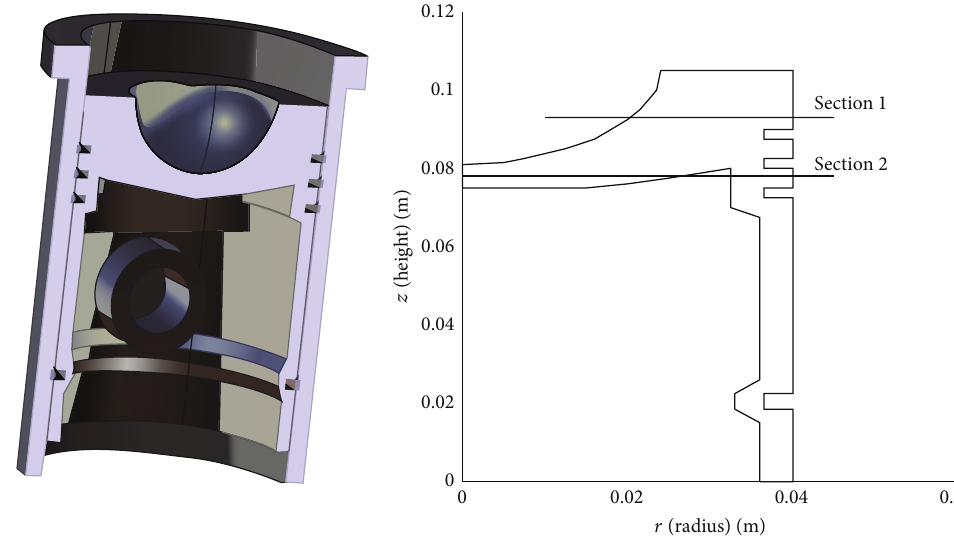
Figure 1: Cutaway view of the piston and cylinder.